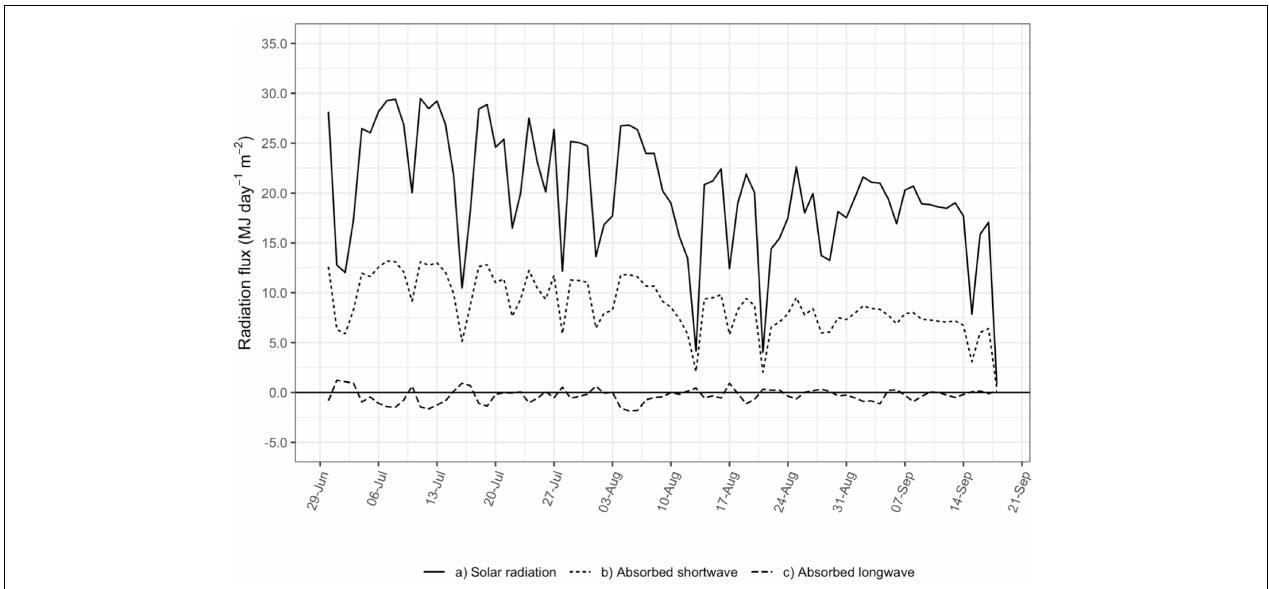
FIGURE 4 | Daily shortwave and long wave radiation flux (MJ day − 1 m − 2 ) absorbed by the vine canopy (dashed lines) and solar radiation flux (MJ day − 1 m - 2 ) incident on the vineyard (solid